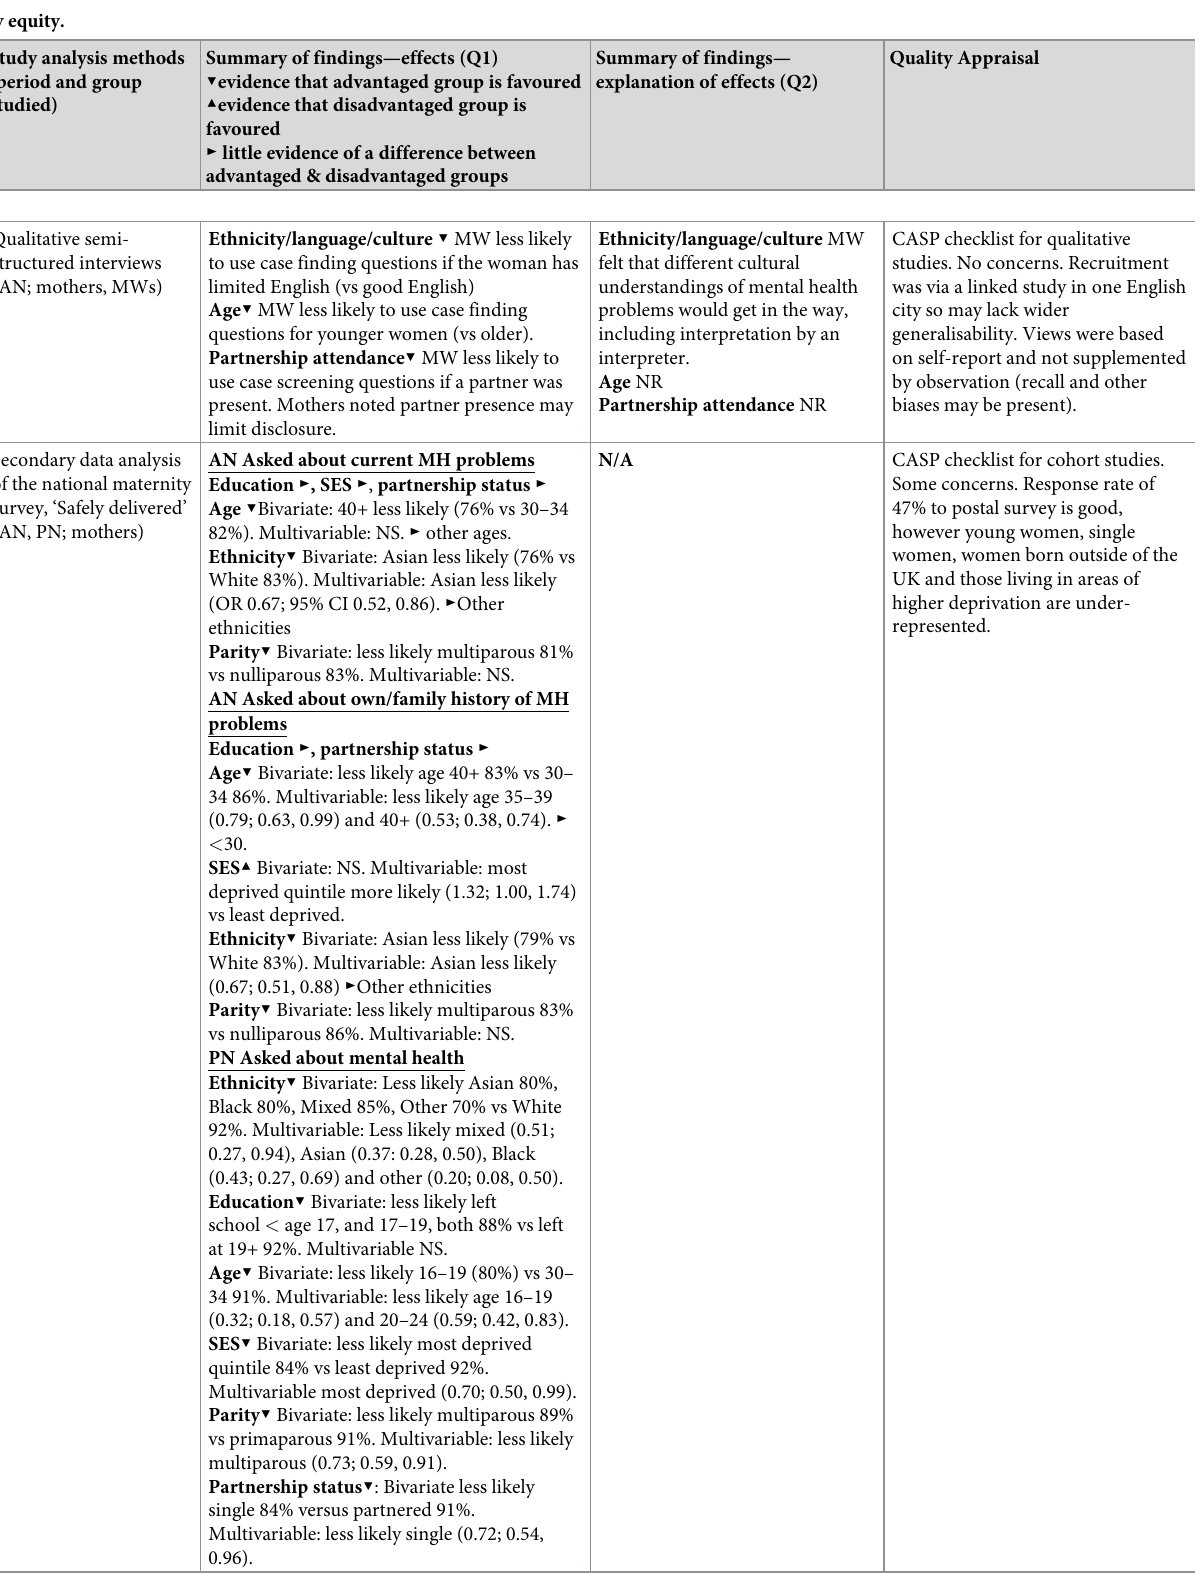
Table 2. Results by